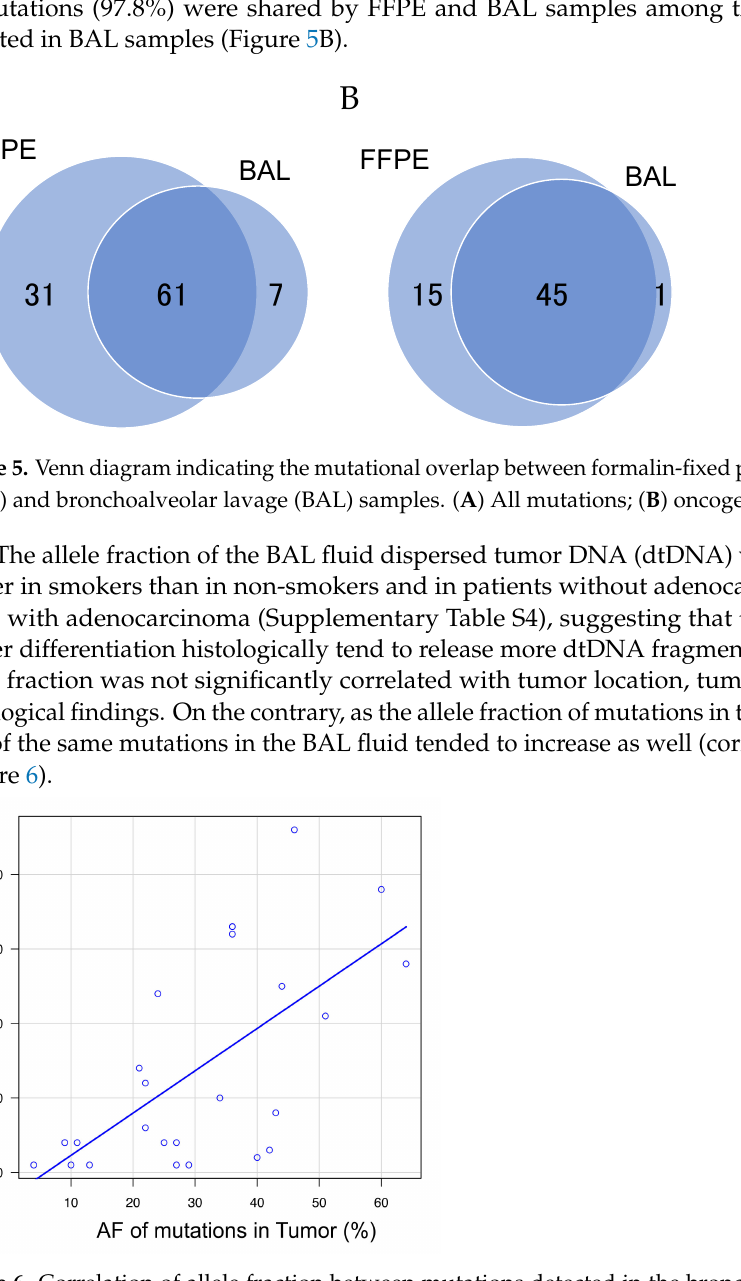
Figure 6. Correlation of allele fraction between mutations detected in the bronchoalveolar lavage (BAL) fluid and